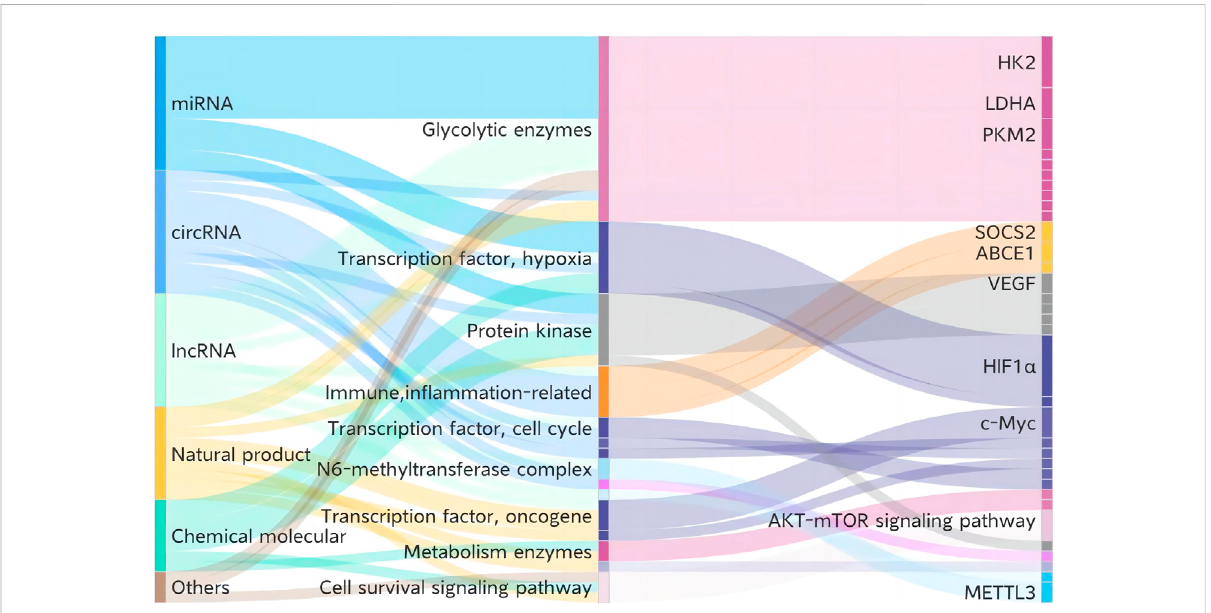
FIGURE 3 Current treatments and candidates targeting glycolysisin NSCLC. HK2, hexokinase 2;PKM2, pyruvate kinase M2;LDHA, lactate dehydrogenase A;SOCS2,suppressorofcytokinesignaling 2;ABCE1,ATP-binding cassettesubfamily Emember1;VEGF,vascular endothelialgrowth factor; HIF-1 α , hypoxia-inducible factor 1 subunit alpha; c-Myc, MYC proto-oncogene; METTL3, methyltransferase